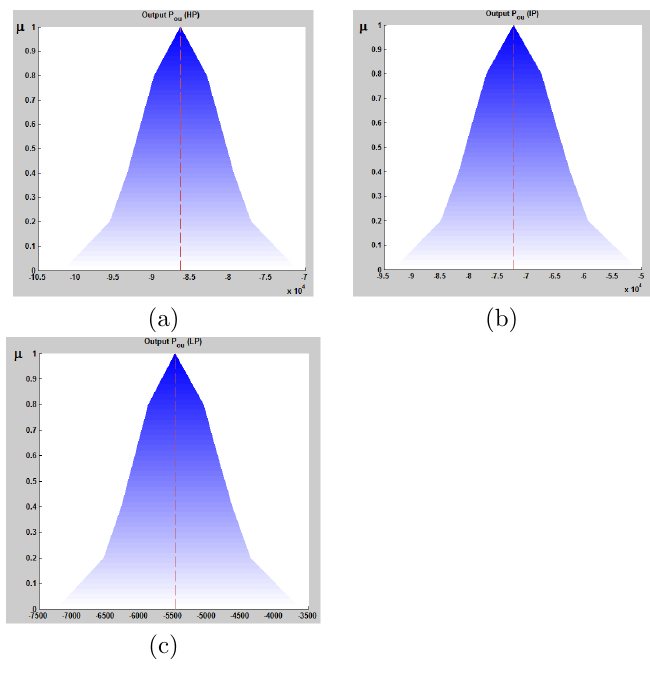
Figure 5. Fuzzy Output P ou of a Steam Turbine System (a) high-pressure, (b) intermediate-pressure, (c) low-pressure.